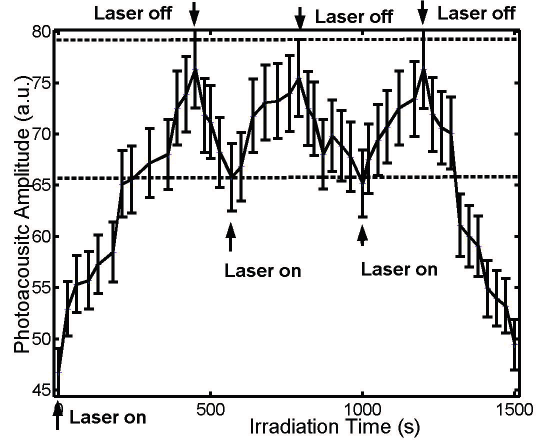
Figure 4. Photoacoustic amplitude versus irradiation time. The laser power for thermal irradiation was 1.24 W. The two dotted lines represent the PA amplitudes for the corresponding temperatures at 41 and 55 °C, respectively, based on the linear relationship between PA signals and temperature (Figure